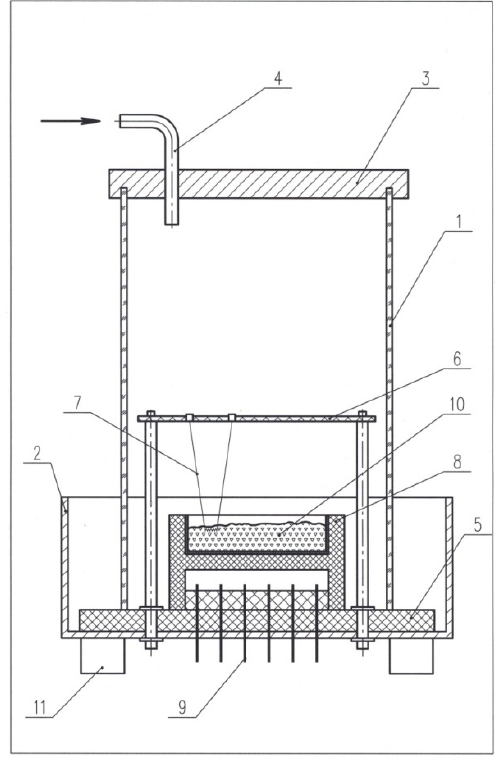
Figure 1. Schematic of the self-propagating high-temperature synthesis (SHS) reactor: 1 – quartz tube; 2 – tray; 3 – lid; 4 – gas sleeve; 5 – refractory plate; 6 – holder of the spiral; 7 – nichrome spiral; 8 – container; 9 – electrodes; 10 – sample; 11 – reactor stand.